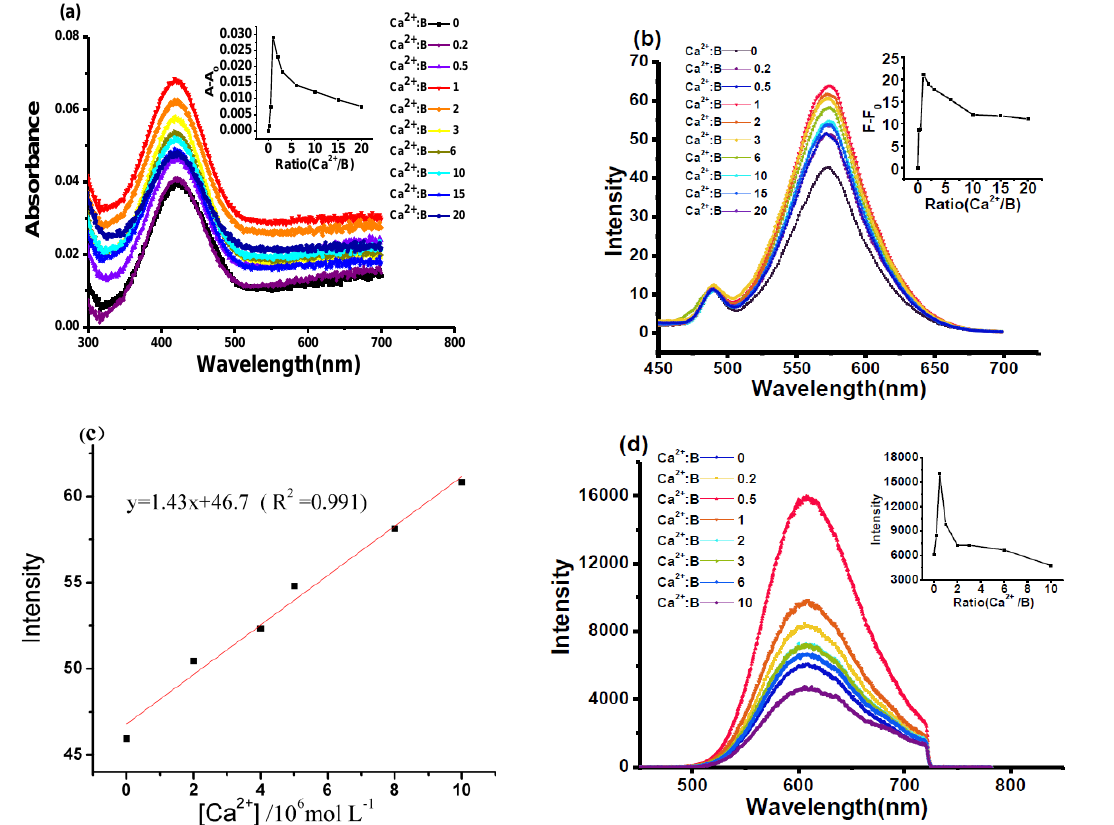
Figure 1. ( a ) Absorption spectra and ( b ) one-photon fluorescence emission spectra of BAPTAVP (B) in tris-HCl bu ff er solution upon 0–20 equiv. of Ca(NO 3 ).4H 2 O pre-dissolved in ultrapure water. Inset in upper right corner of ( a ) is the absorption at 420 nm evolution with Ca 2 + concentrations; inset in upper right corner of ( b ) is the fluorescent intensity at 570 nm evolution with Ca 2 + concentrations. ( c ) Linear fitting curve of the fluorescent intensity against the concentrations of Ca 2 + ; ( d ) two-photon (TP) fluorescent emission spectra of the BAPTAVP in tris-HCl bu ff er solution upon 0–10 equiv. of Ca(NO 3 ).4H 2 O pre-dissolved in ultrapure water. In set in upper right corner of ( d ) is the plot of fluorescent intensity evolution with Ca 2 + concentrations.